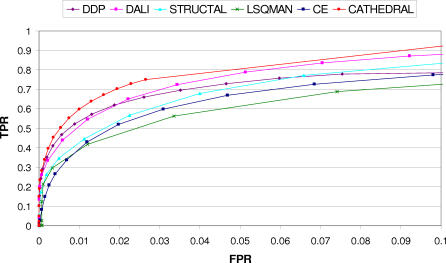
ROC (True Positive Rate Versus False Positive Rate) Curve Plotted for Different Structural Comparison Methods Based on the SAS, Where a Positive Match Represents a True CATH–SCOP Fold MatchTPR, true positive rate; FPR, false positive rate.